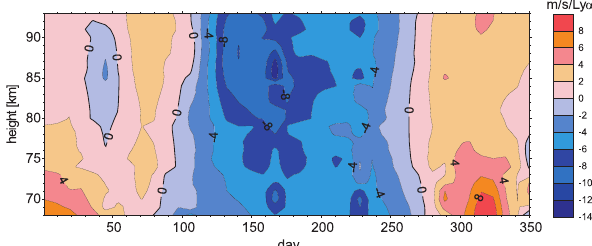
Fig. 4. Mean height-time cross section of the partial regression co- efficient b (see Eq. 1) between the mesospheric zonal wind at Julius- ruh and the solar activity.